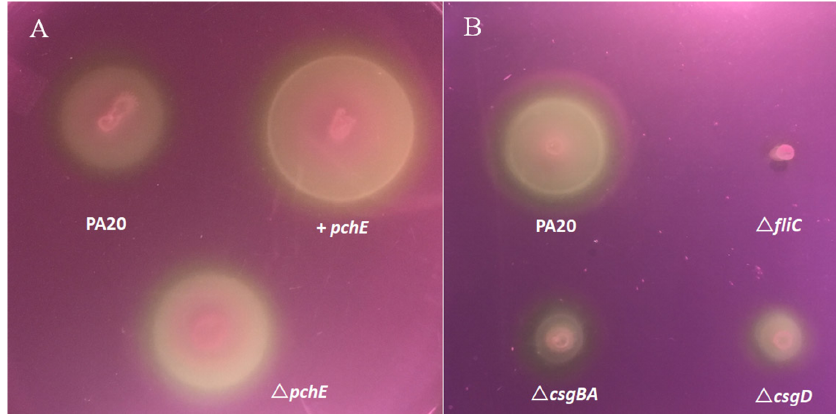
Figure 2. Strain swimming motility in EMEM soft agar incubated for 11 h at 37 ◦ C. ( A ) Comparison of strains PA20 pSE380 (PA20), PA20 ∆ pchE ( ∆ pchE ) , and PA20 pSE380:: pchE ( + pchE ) spotted on soft agar. ( B ) Comparison of strains PA20, PA20 ∆ fliC ( ∆ fliC ), PA20 ∆ csgBA ( ∆ csgBA ), and PA20 ∆ csgD ( ∆ csg D ) spotted on soft agar.